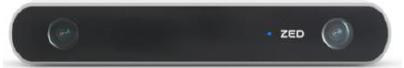
Figure 1. ZED stereo camera by https://www.stereolabs.com/